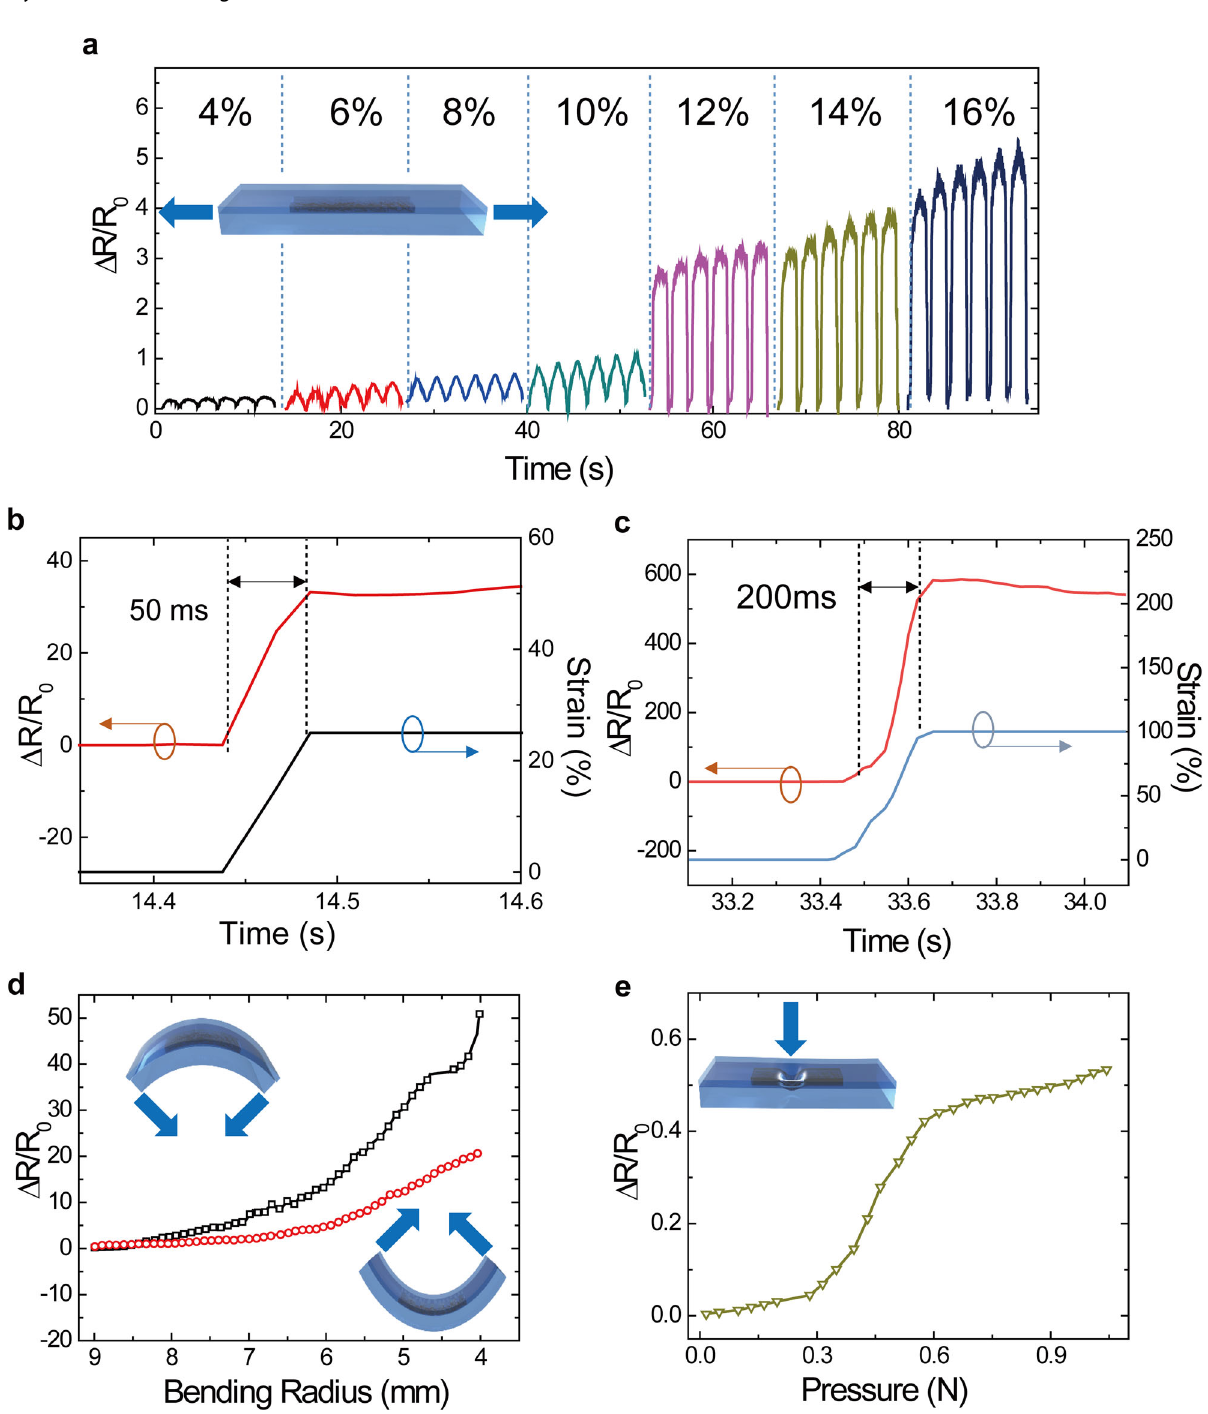
Fig. 3 Relative changes in the sensor resistance under various dynamic loadings: a Relative change in the resistance under different strains. b Instant response to small stretching, i.e., the resistance of the strain sensor (blue) for 0 – 25% strain (red). c Instant response to large stretching, i.e., the resistance of the strain sensor (blue) for 0 – 100% strain (red). d Relative change in the resistance for a bending radius of 5 − 9 mm with tension (black line) or compression (red line). e Relative change in the resistance of the NMH strain sensor under pressure (0 – 1